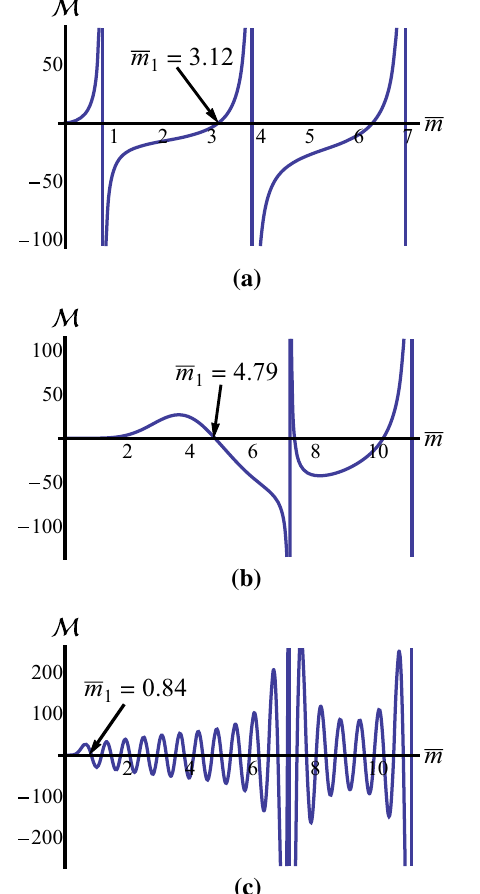
Fig. 6 Theeffectoftheparameter τ andthesizeoftheextradimension ¯ z b onthemassivevectorKKmodes,andtheparameter k issetto k